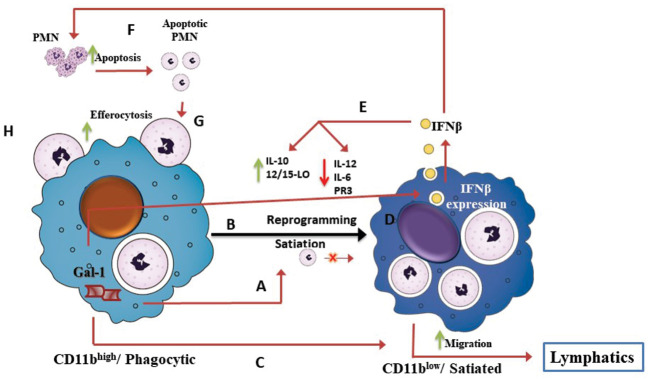
The Gal-1-IFN-β axis drives macrophage reprogramming during the resolution of inflammation. Schematic illustration of our current understanding of the role of the Gal-1-IFN-β axis in macrophage reprogramming during resolution of inflammation, based on our current findings and recent reports (Schif-Zuck et al., 2011; Ariel and Timor, 2013; Rostoker et al., 2013; Kumaran Satyanarayanan et al., 2019). Acute inflammation is characterized by recruitment of short-lived polymorphonuclear (PMN) cells, which in turn, undergo apoptosis and engulfment by pro-inflammatory monocytes/macrophages that converts them to reparative/phagocytic/CD11bhigh macrophages. CD11bhigh/phagocytic macrophages produce Gal-1 (A) that promotes macrophage satiation and reprogramming to the pro-resolving/CD11blow phenotype (B). Gal-1 also promotes macrophage migration to lymphatics (C). Our study suggests that Gal-1-induced apoptotic PMN uptake triggers a positive feedback loop, mediated by IFN-β. The uptake of apoptotic PMN triggers IFN-β production and secretion (D). IFN-β, in turn, mediates Gal-1-induced macrophage reprogramming (E), PMN apoptosis (F), and efferocytosis (G). Validation that all these steps of the Gal-1-IFN-β feedback loop take place in a coordinated fashion requires further investigation.